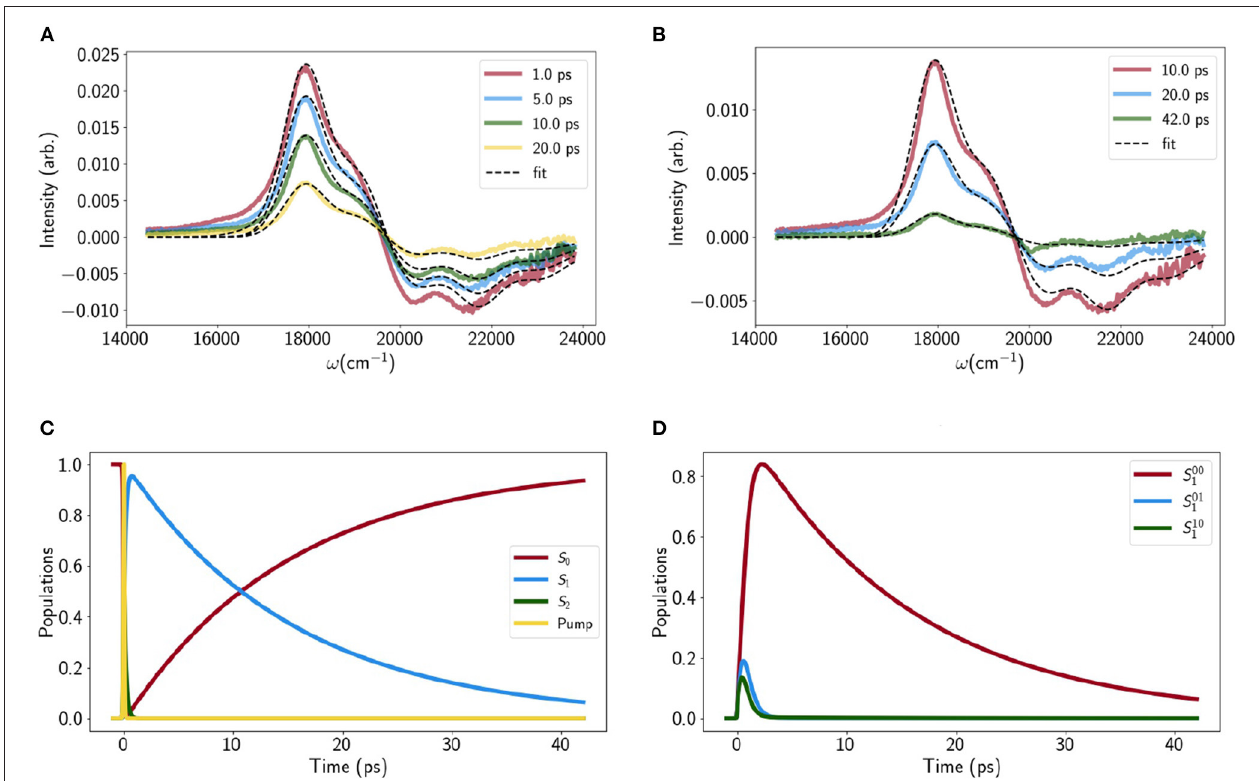
FIGURE 2 | Transient absorption traces for (A) medium times and (B) long times, with experimental data shown in solid, colored lines and model fits shown as dashed lines. (C) The evolution of the total population on each electronic state as a function of time, along with the temporal shape of the pump pulse. Note that a S 1 decay (green line) overlaps with the pump. (D) Population evolution of the 3 lowest vibrational levels on S 1 large part of the S 2 →